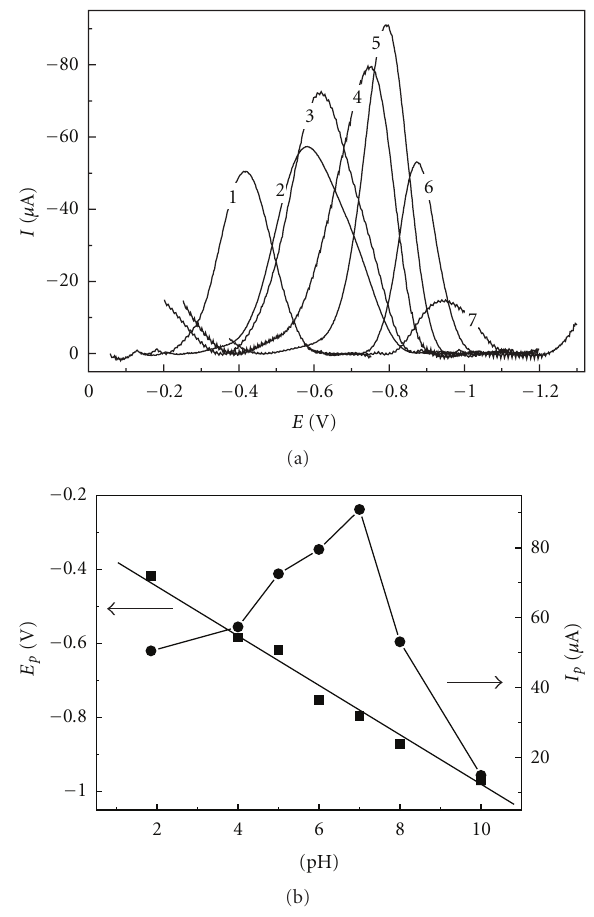
Figure 2: (a) Square wave voltammogramsfor 1.05 × 10 − 4 moLL − 1 4-NP, using a 0.1moLL − 1 BR bu ff er solution at di ff erent pH values and f = 100s − 1 , a = 50mV, and Δ E s = 2mV for the AgSAE, and (b) relationshipsbetween the pH values and the peak currents (right y -axis) and potentials (left y -axis).